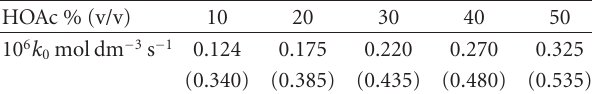
Table 4: E ff ect of variation of solvent composition. 10 3 [NBS]